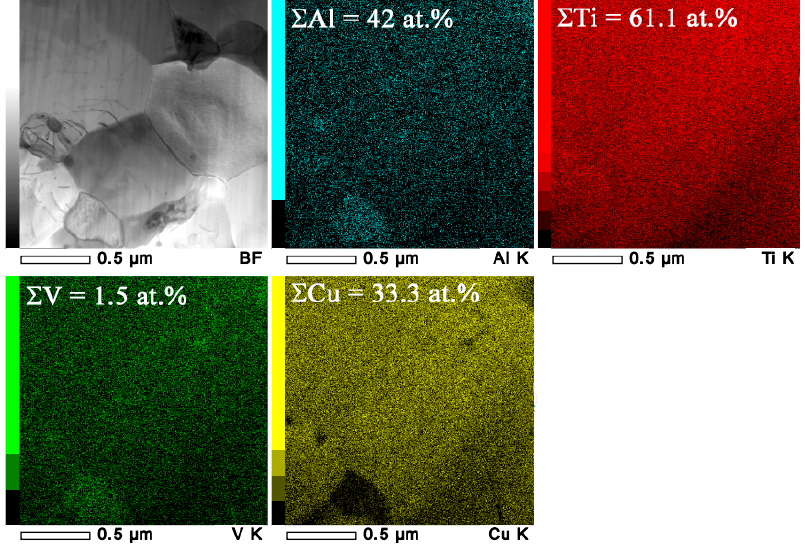
Figure 9. TEM bright field image of area in the middle SZ2 part and corresponding EDS element distribution maps Along with submicron-sized equiaxed α and β grains that contained numerous dis- locations and extinction contours that resulted from the dynamic recrystallization, several elongated and almost dislocation-free β -grains could be found in this part of the SZ (Fig- ure 10a,b). It is suggested that these dislocation-free grains were the result of static recrys- tallization that occurred after the metal stirring stopped. Such secondary recrystallization may have been more likely with the multi-pass FSP when too much strain accumulated in a particular grain. The atomic copper distribution in Figure 10c shows that these defect- less statically recrystallized β grains contained more copper as compared to the dynami- cally recrystallized grains and, therefore, were more thermodynamically stable. A higher concentration of copper atoms could be observed below that β grain in a zone occupied by the Ti 2 Cu IMCs. However, copper regions with even greater richness could be found in SZ2, with a total Cu/Ti concentration ratio close to 0.4, which allowed for suggesting the formation of TiCu 2 IMCs in them (Figure 10d). Numerous dislocation loops were pre- sent in these regions, which might have resulted from the clustering of the vacancies gen- erated by a migrating boundary during the IMC grain growth.